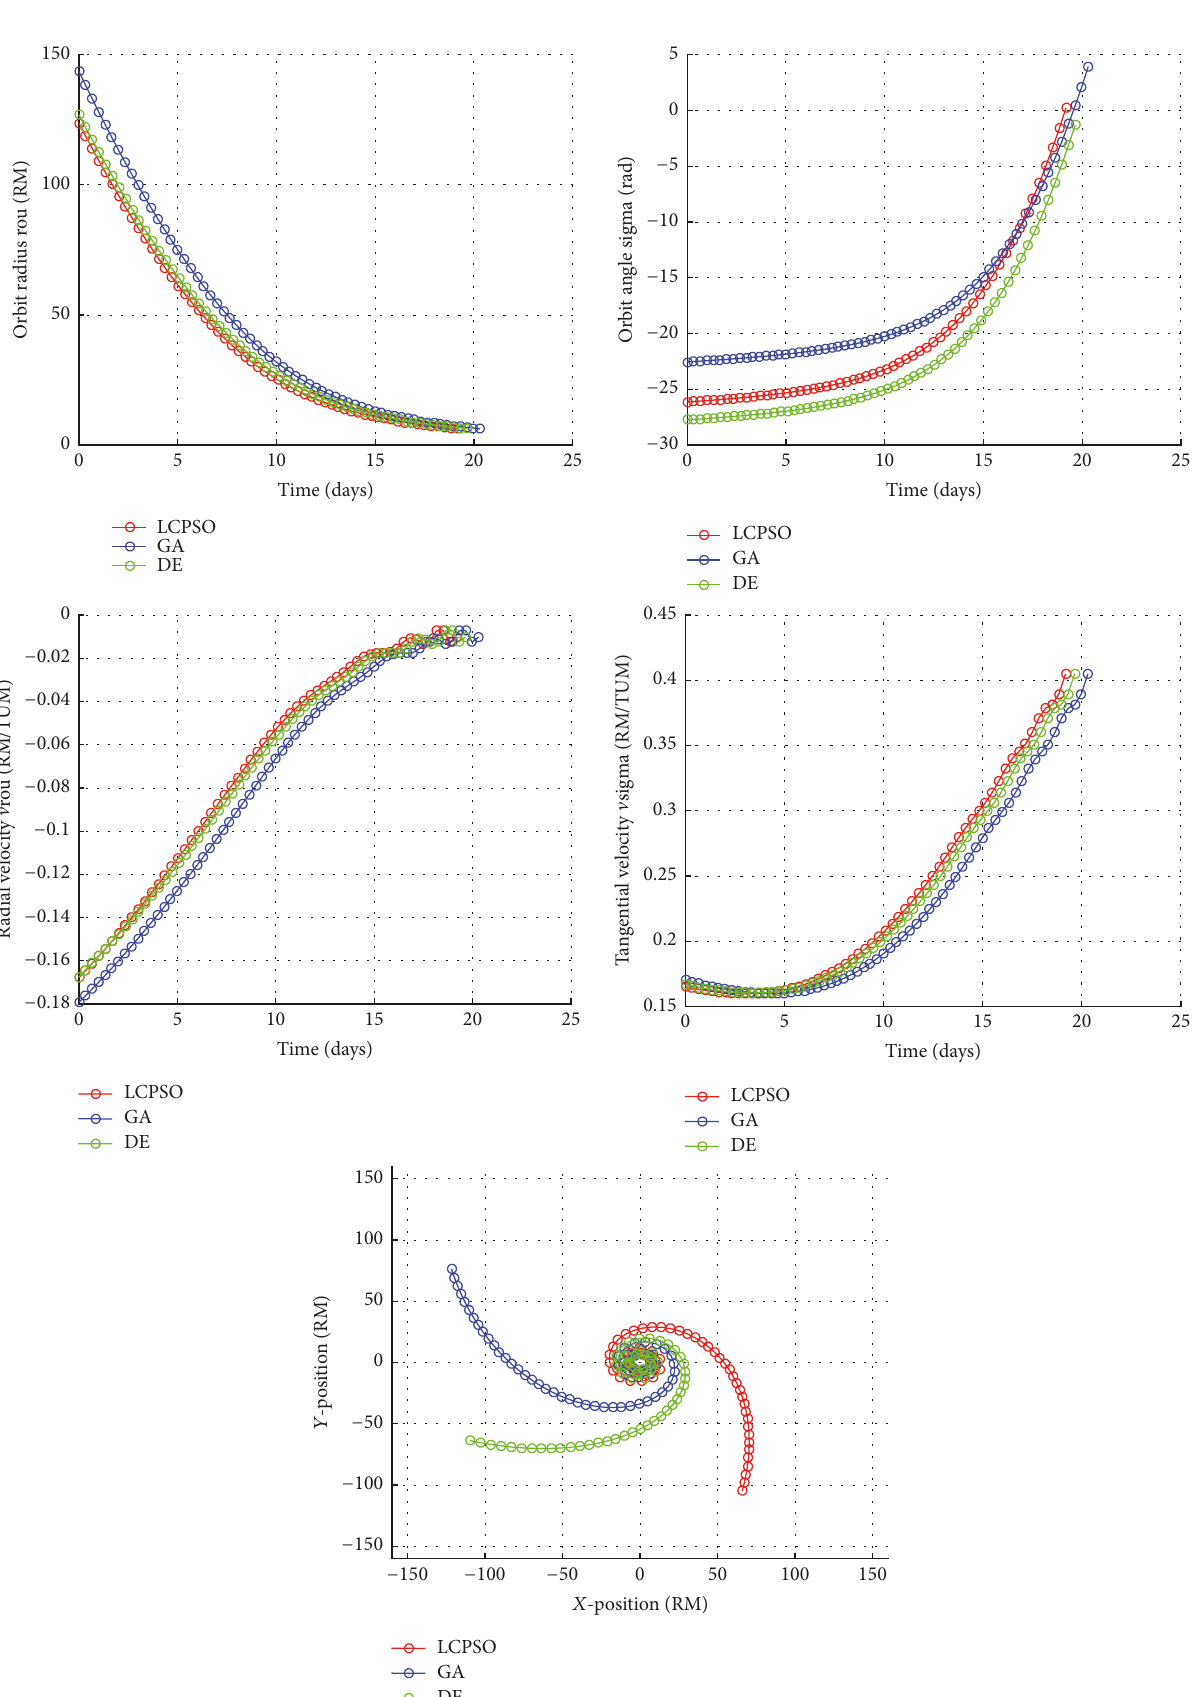
Figure 9: State variables in areocentric